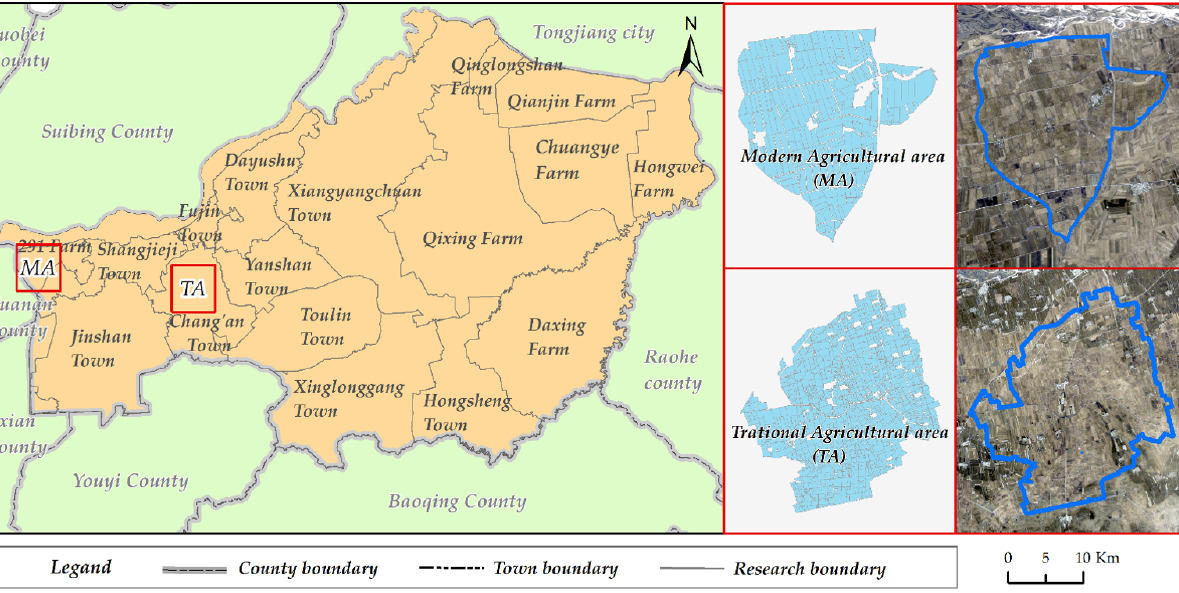
Figure 2. Locations of modern agricultural area and traditional agricultural area in Fujin